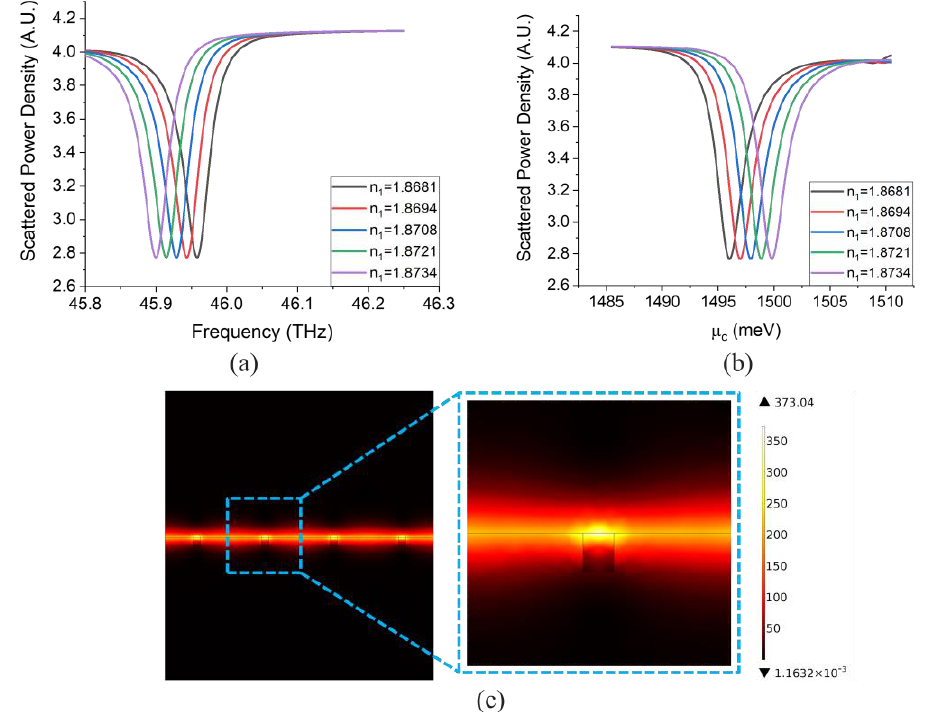
Figure 7. ( a ) SCS for a device with 40 unit-cells and reflector working in the optical mode of operation with µ c = 1500 meV. ( b ) Scattered power density for the same device working in the electrical mode of operation with the same chemical potential. ( c ) Simulated electric field intensity at the GSPR peak when (cid:15) 1 = 3.5 ( n 1 = 1.87).